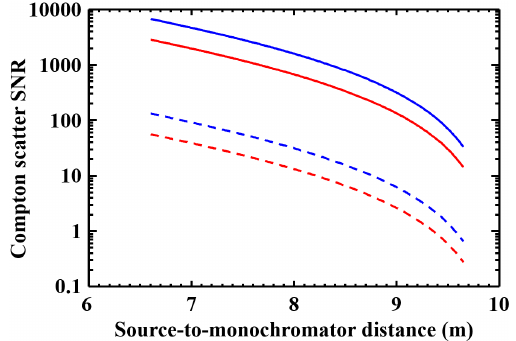
FIG. 12. Calculated Compton scatter SNR as a function of the source-to-monochromator distance with a fixed source-to- detector distance for a single Bragg (solid curves) and a single Laue Si (1,1,1) monochromator (dashed curves). The blue curves are for the unfiltered beam, and the red curves are for the filtered beam. Calculations are performed with storage ring energy 6 . 0 GeV, storage ring current I 0 . 2 A, and the bend E ring ¼ ring ¼ magnet field B 0 ¼ 0 . 657